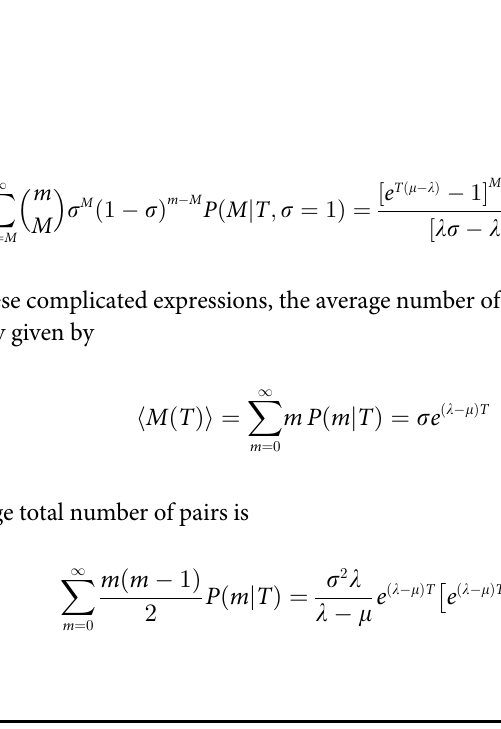
Fig 2. An example of the rooted Yule tree of age T . Filled circles (1, 3, 5, 7 and 8) denote observed leaves. Empty circles (2, 4 and 6) denote survived but not observed leaves. Short horizontal lines denotes an extinction event. Long, dashed horizontal lines denote the origin of the tree, the first branching event and the time of sampling the tree, from top to bottom. After the first branching at time T 1 the two resulting subtrees both encompass M 1 = M 2 = 4 leaves. However, the number of observed leaves is 2 (leaves 1 and 3) for the left subtree and 3 (leaves 5, 7 and 8) for the right one. The thick green line denotes the pairwise evolutionary distance between the two observed leaves 5 and 7. The horizontal dimension is meaningless. In this example for leaf 1 the first closest observed leaf is 3, the second (as well as the third and the fourth) is 5 (or 7 or 8). The tree has two observed cherry pairs: (1, 3) and (7, 8).